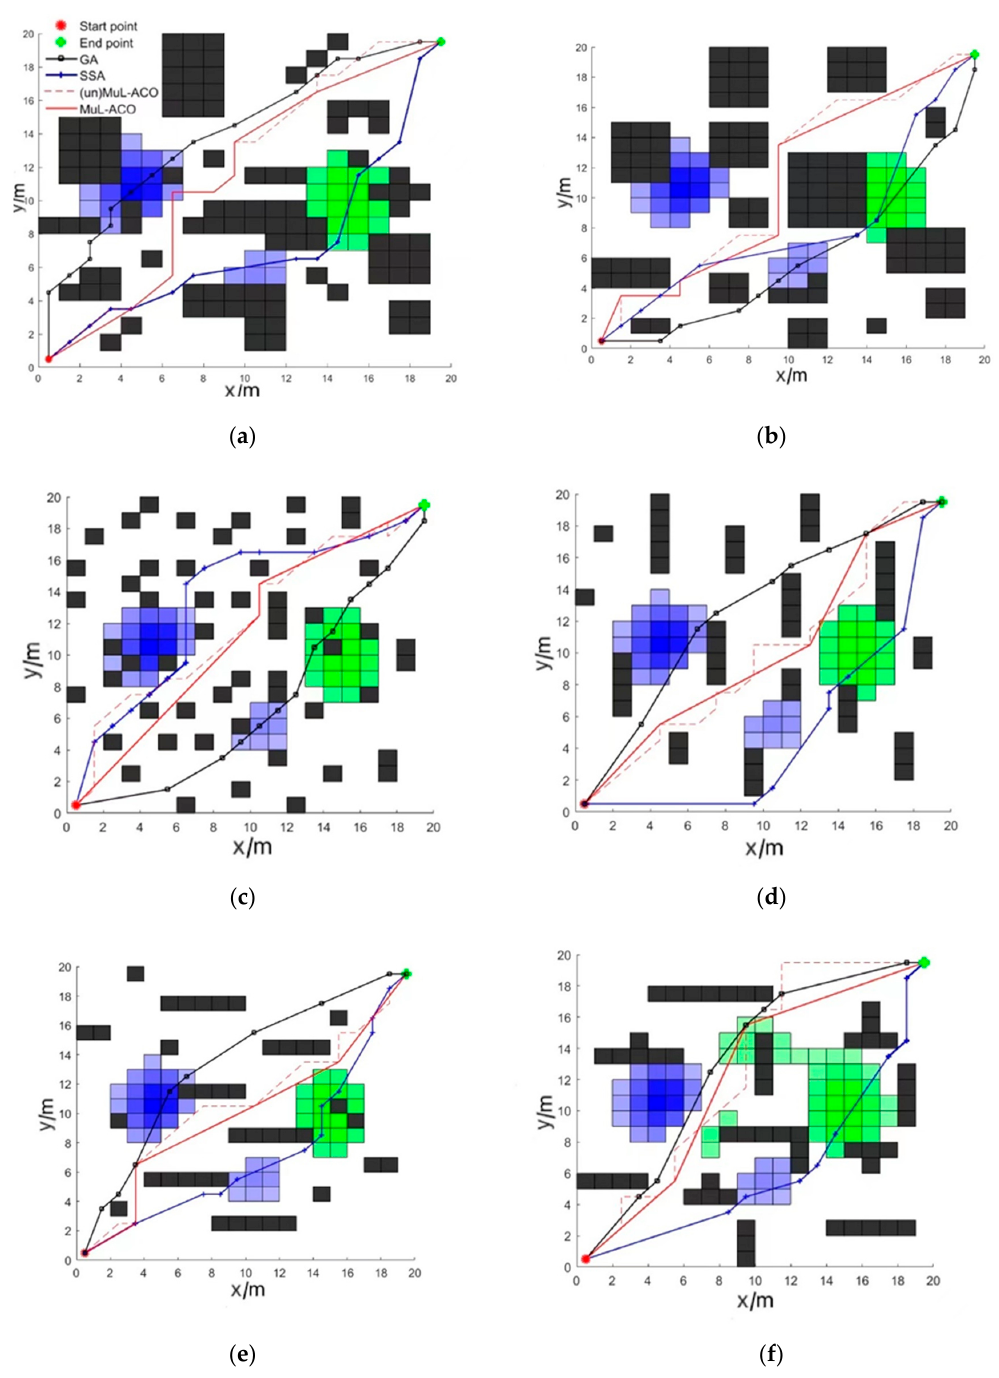
Figure 8. ( a – f ) Optimal trajectories generated by GA, SSA, and MuL-ACO on different 20 × 20 maps. Table 2. Simulation results of GA, SSA, and MuL-ACO.